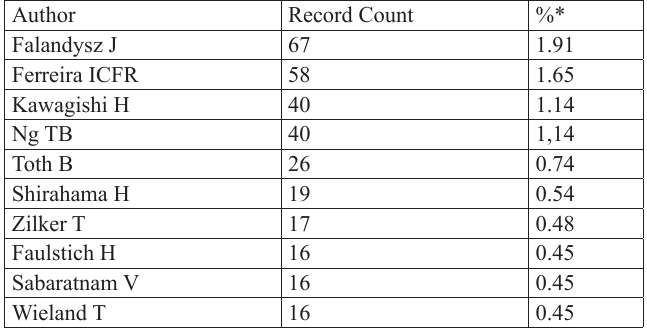
Figure 2 - Top ten contributor countries in productivity of literature